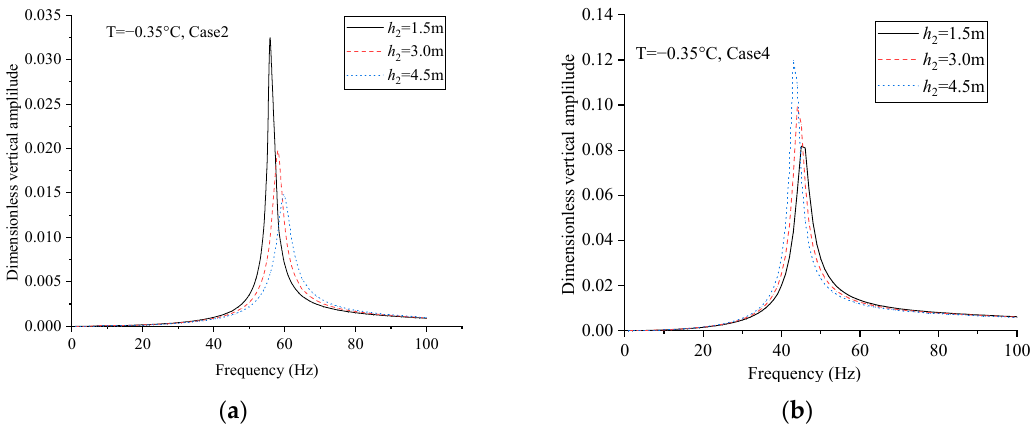
Figure 6. Effects of the depth of the active layer on the amplitude–frequency curves of the pile foundation. ( a ) Freezing depth of seasonally frozen soil and ( b ) thawing depth of permafrost.